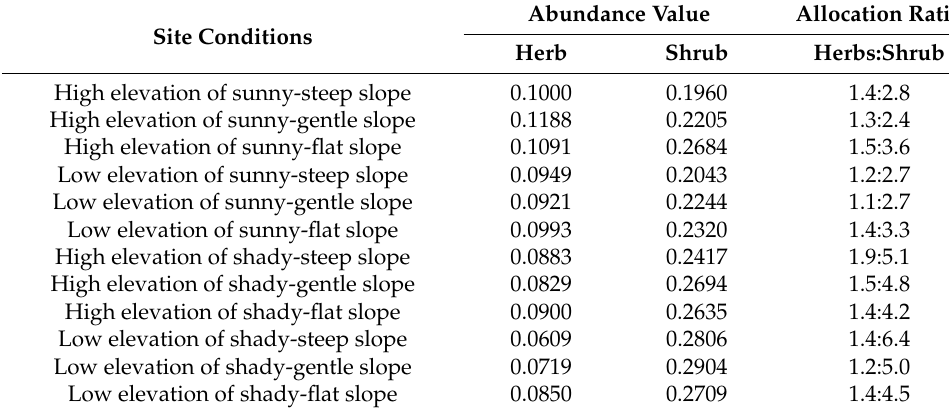
Table 1. Restoration abundance threshold and plant allocation ratio at different site conditions [67].